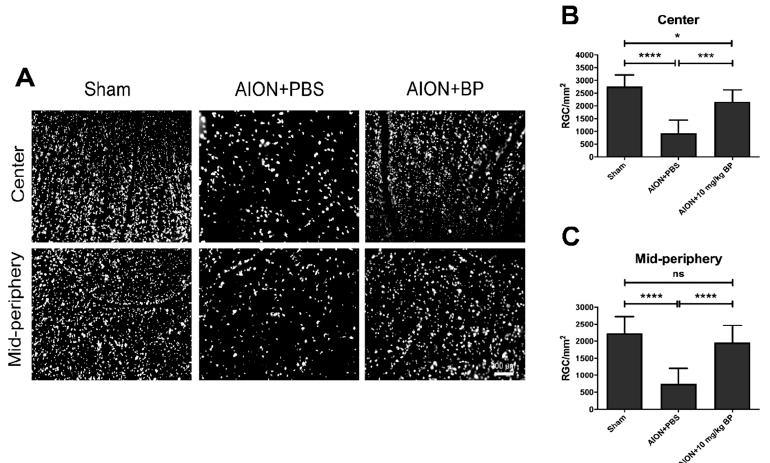
Figure 1. The RGC density in the whole retina was evaluated in the rAION model to detect the therapeutic effects of BP. Qualitative images of the central and mid-peripheral retina in each group ( A , B ). Quantitative graphs of RGC density in the central retina in the sham, PBS-treated, and BP- treated groups were 2771 ± 453/mm 2 , 935 ± 514/mm 2 , and 2172 ± 458/mm 2 , respectively ( C ), and those in the mid-peripheral retina were 2236 ± 485/mm 2 , 750 ± 452/mm 2 , and 1962 ± 505/mm 2 , respectively. (*, p ≤ 0.05; ***, p ≤ 0.001; ****, p < 0.0001; n.s., not significant; n =